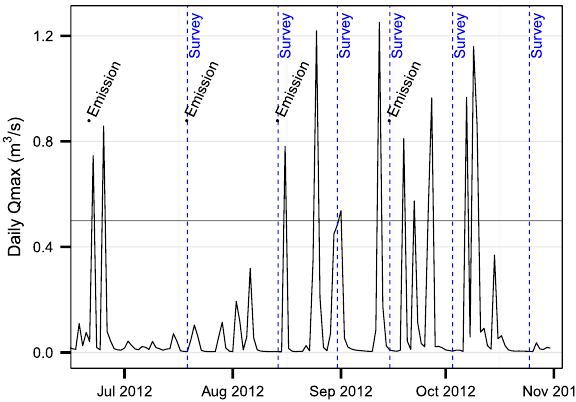
Figure 3. Daily peak discharge of the Erlenbach between 20 June and 31 October 2012 measured at the gauging station. According to Rickenmann and McArdell (2007) as well as Turowski et al. (2011), the critical discharge for the start of bedload transport amounts to approximately 0.5m 3 s − 1 (horizontal bold black line). The dates of tracer emissions and surveys are